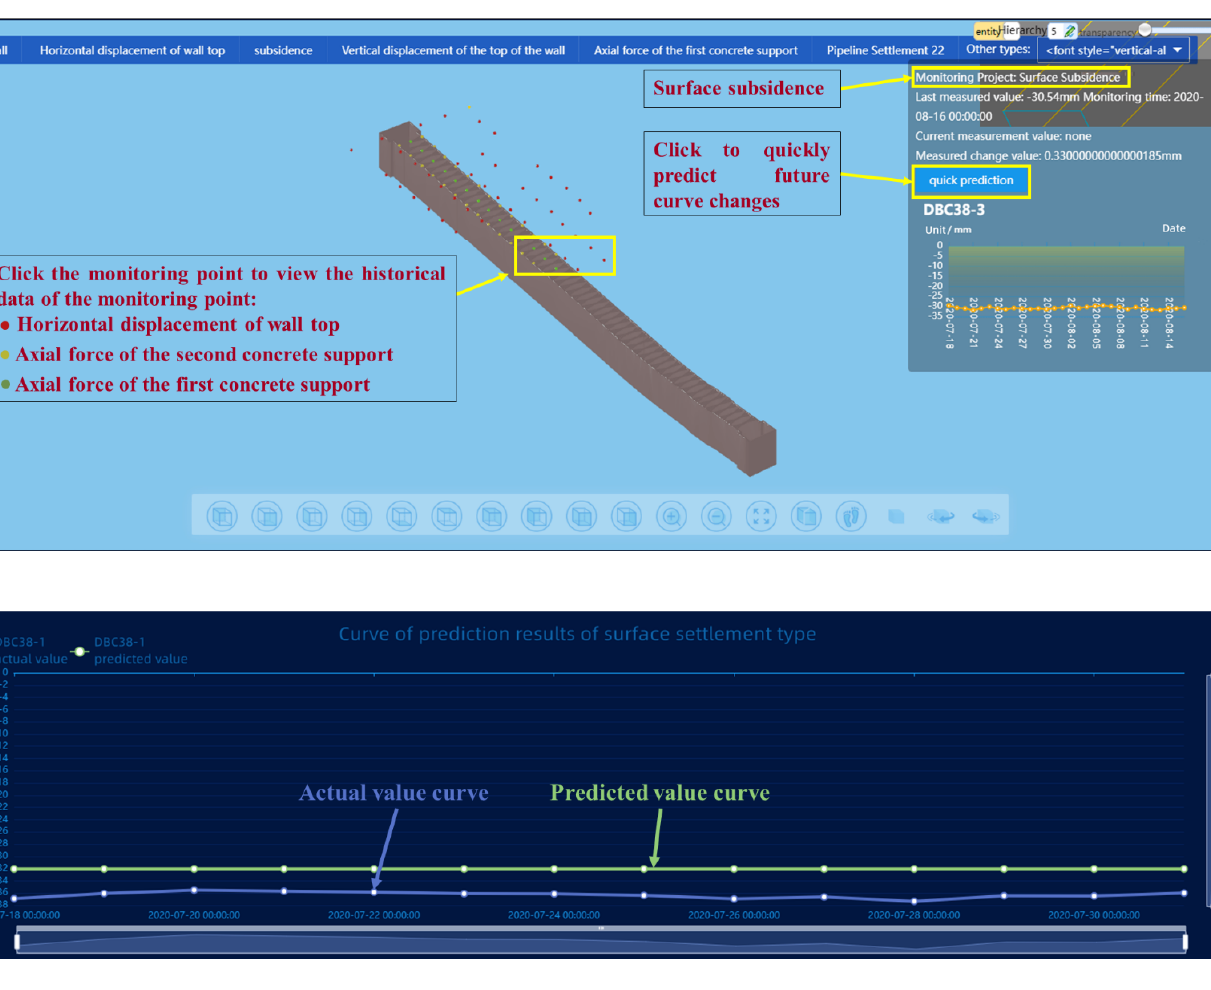
Figure 7. ( a ) Monitoring hotspot map. ( b ) Algorithm back-testing function (comparison of monitoring and prediction curves).